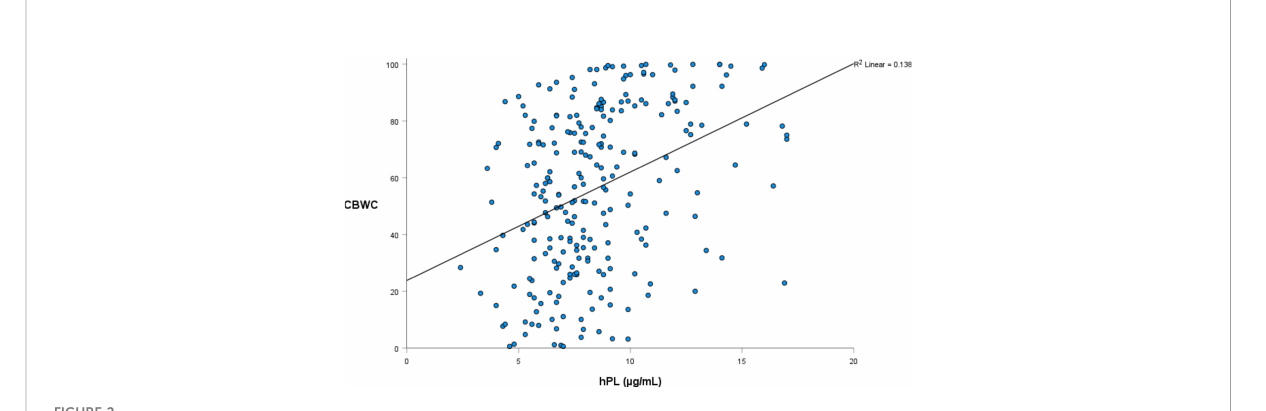
FIGURE 2 The relationship between hPL (µg/mL) and infant custom birthweight centile.